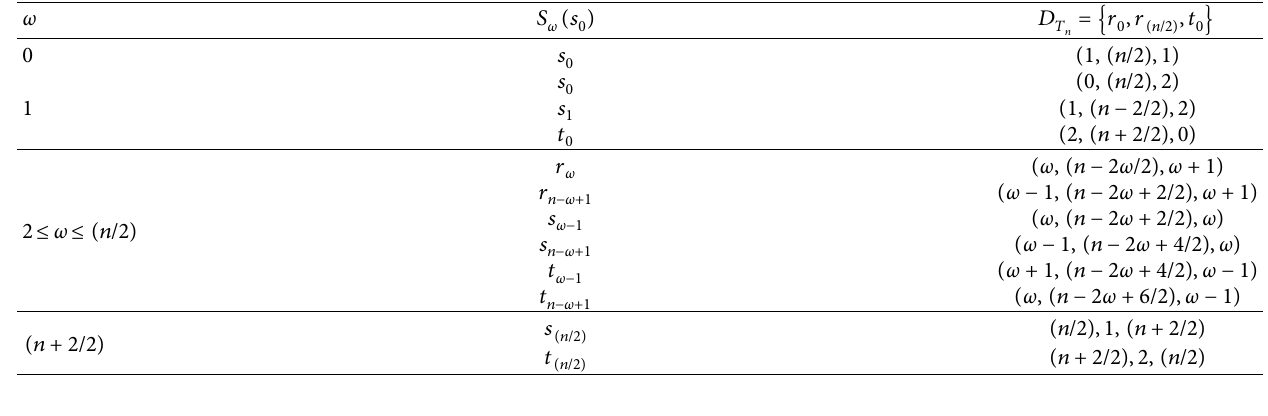
Table 3: Metric coordinate vectors of T